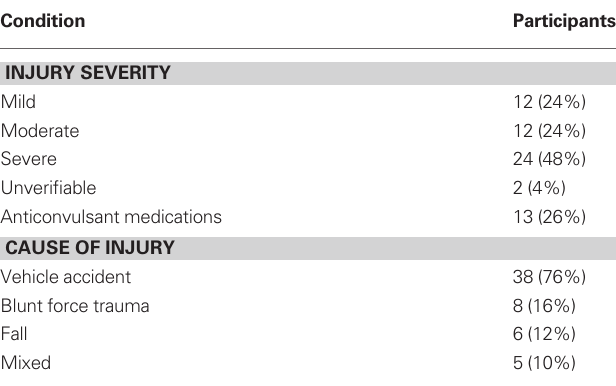
Table 2 | Injury severity, patients taking anticonvulsant medications, and cause of injury information for participants with TBI.